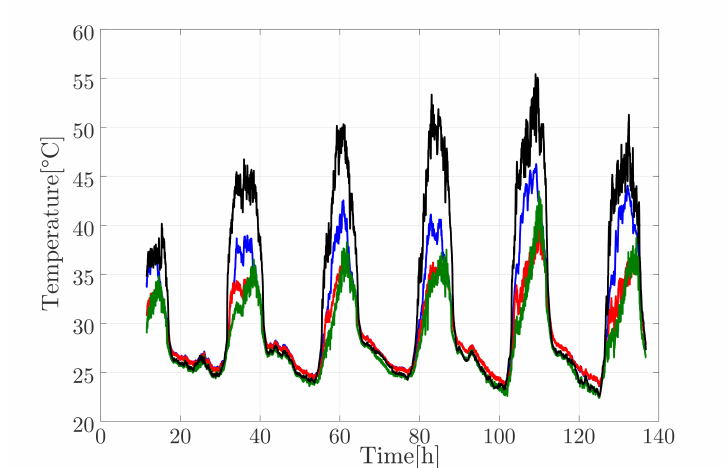
Figure 3. Internal, external, and surface temperatures of the